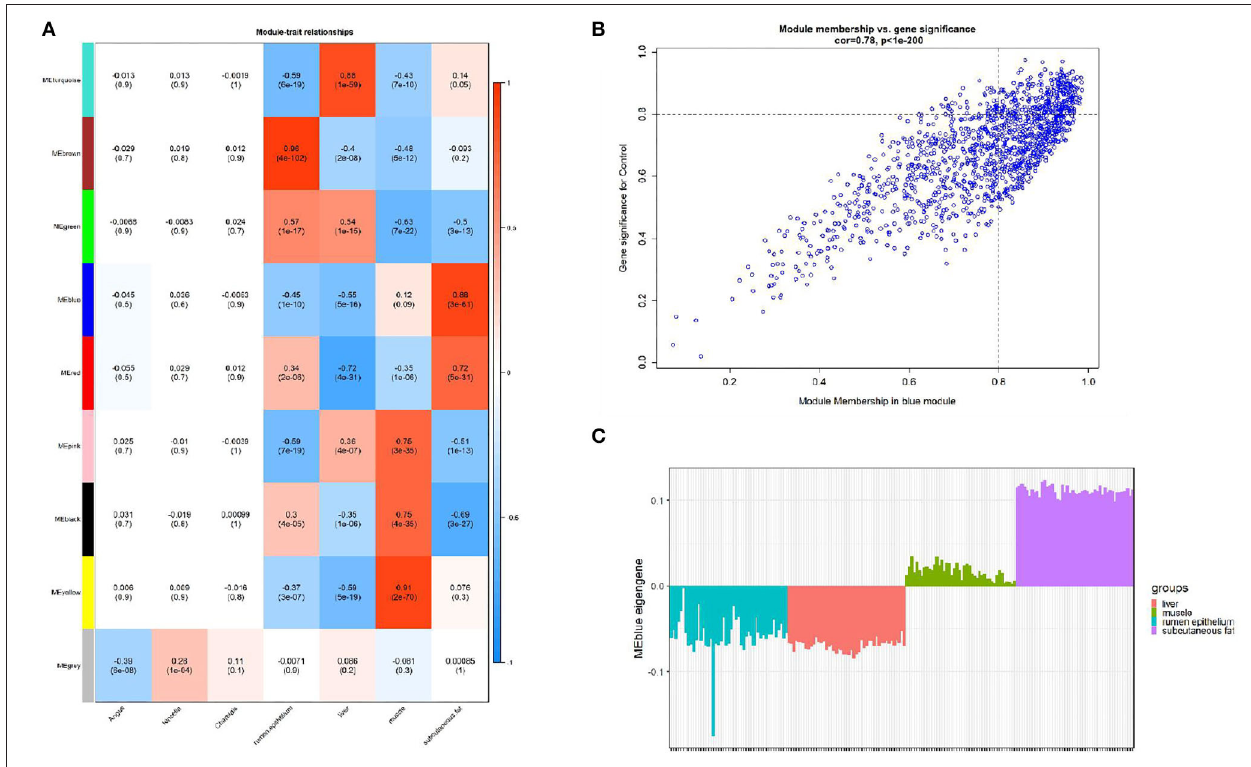
FIGURE 3 | Module-trait correlations analysis in subcutaneous adipose tissue (GSE116775). (A) The correlation heat map between the module and subcutaneous adipose tissue (each unit contains the correlation coefficient and the corresponding P value); (B) The significance of genes related to subcutaneous adipose tissue in the blue module (a dot represents the genes in the blue module); (C) Module eigengene (y-axis) across samples (x-axis) from the blue module (associated to Subcutaneous fat tissue).